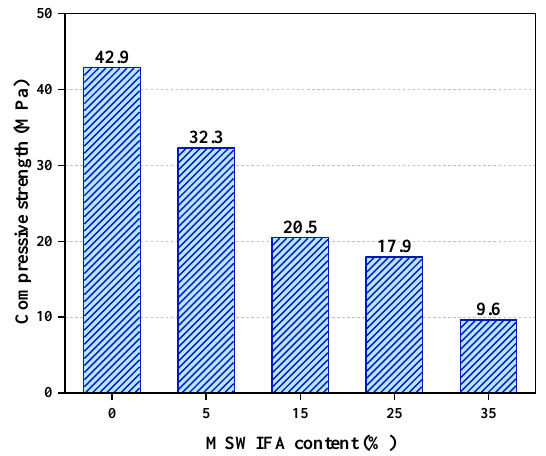
Figure 3. The compressive strength of geopolymer mortars.